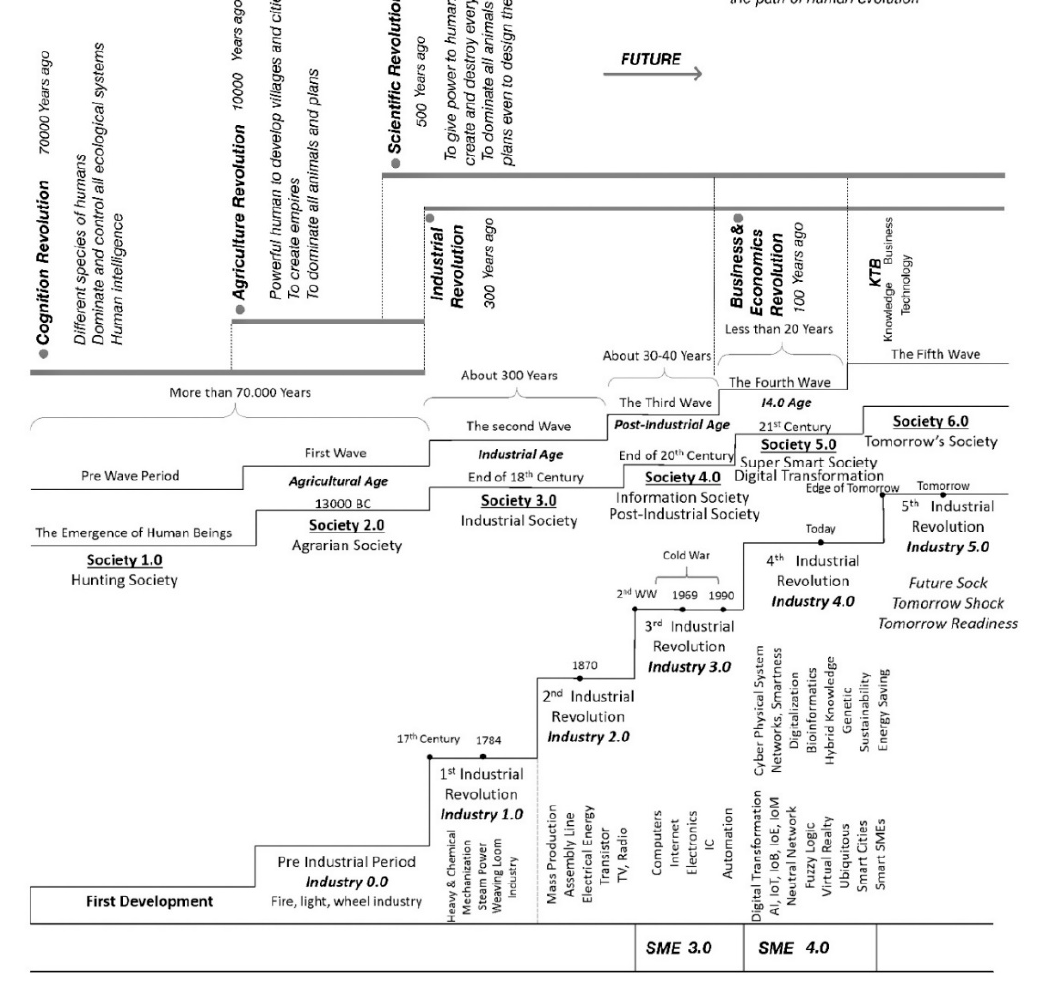
Figure 4. The 5th wave/tomorrow age Theory and Evaluation of Ages (Hamid Doost Mohammadian, [9,41,42]).